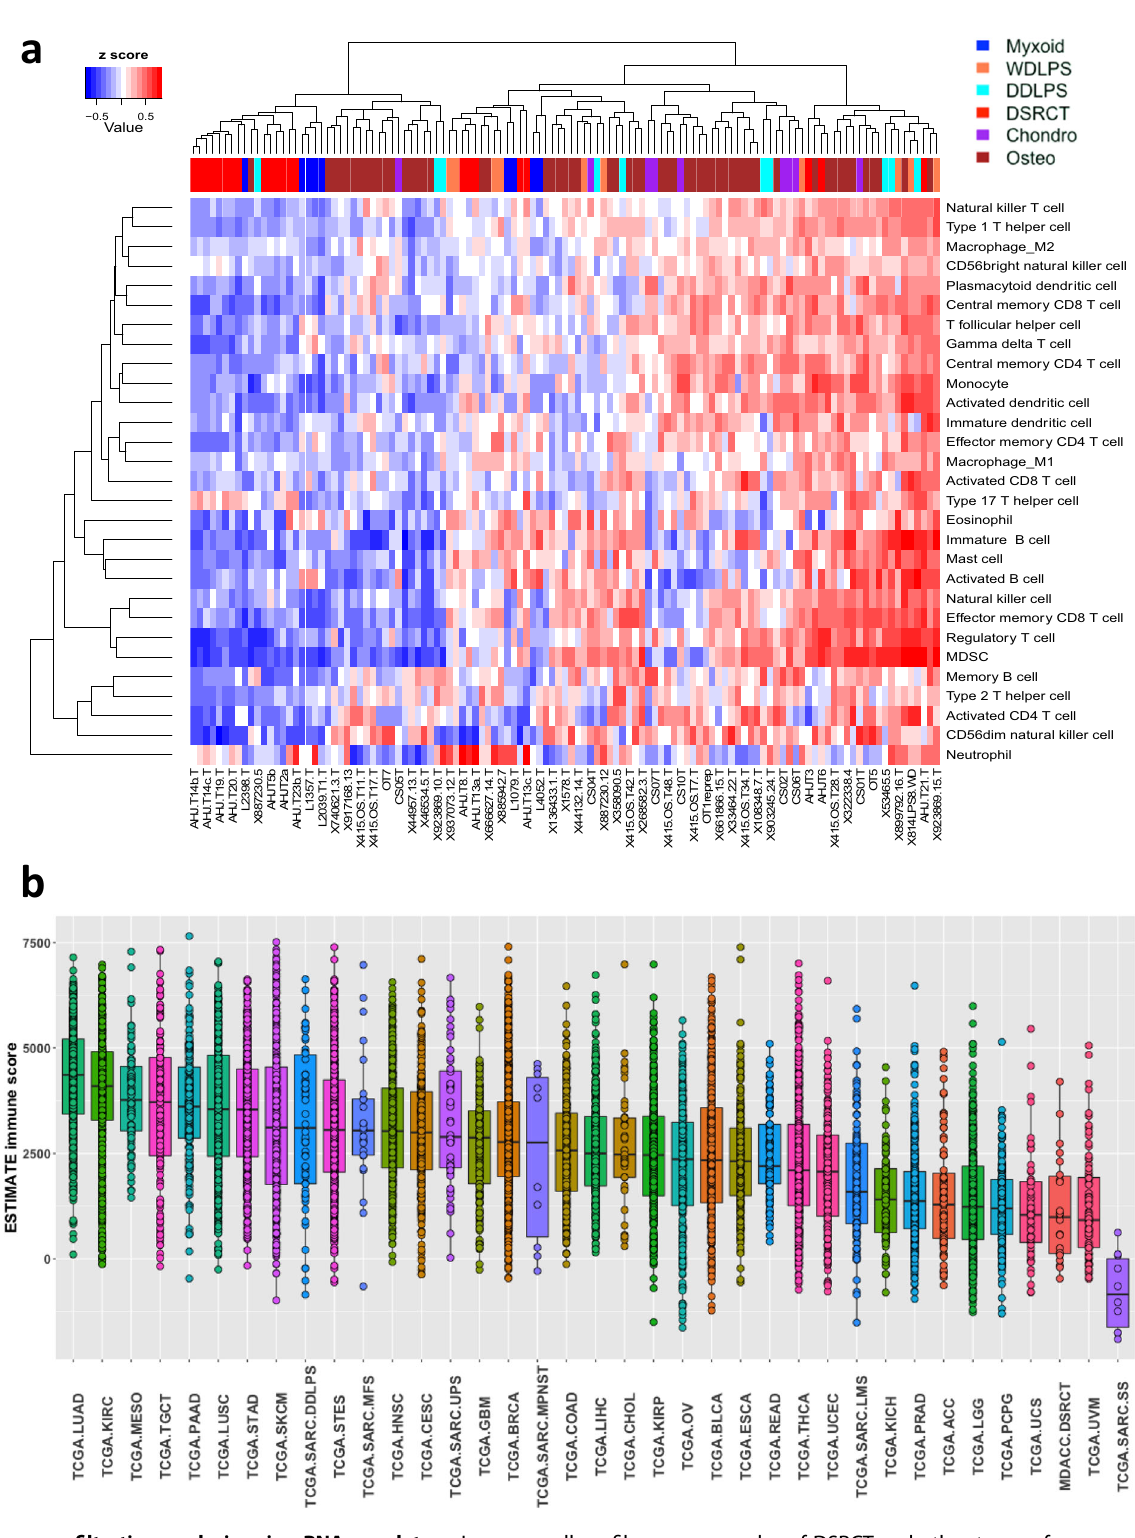
Fig. 4 Immune fi ltration analysis using RNA-seq data. a Immune cell pro fi le across samples of DSRCT and other types of sarcoma samples from MD Anderson (MDACC). Immune cell pro fi les were characterized using single-sample GSEA scores of immune cell gene sets. DDLPS, dedifferentiated liposarcoma; Osteo, osteosarcoma; WDLPS, well-differentiated liposarcoma; Myxoid, myxoid liposarcoma; Chonro, chondrosarcoma. b ESTIMATE immune fi ltration scores in our DSRCT samples and samples of different TCGA tumor types. Each boxplot shows center line as the median, box limits as upper and lower quartiles of the immune fi ltration scores for each TCGA tumor type. Abbreviations of the tumor types are de fi ned in Supplementary Table